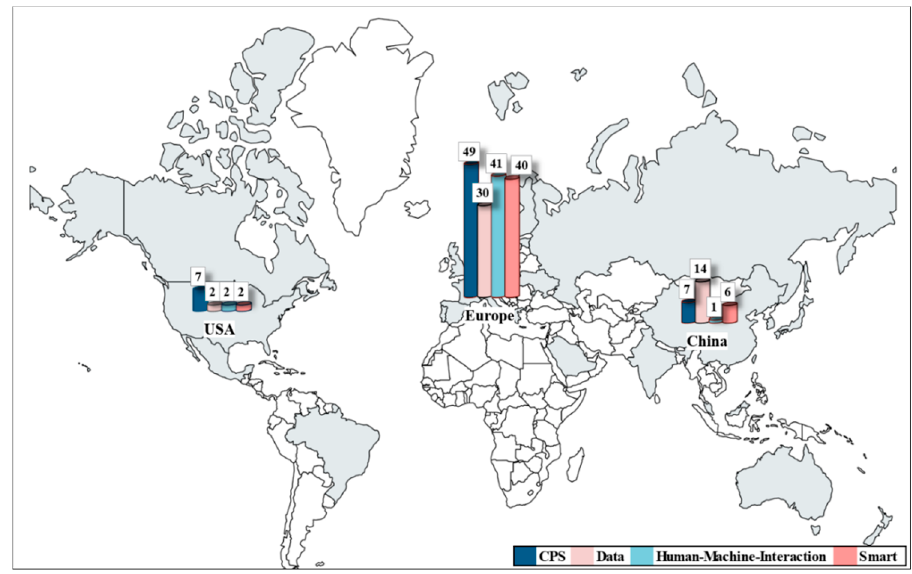
Figure 7. Papers identified in the correlated international analysis (worldwide scale). Sources of the shapefile [38,39].